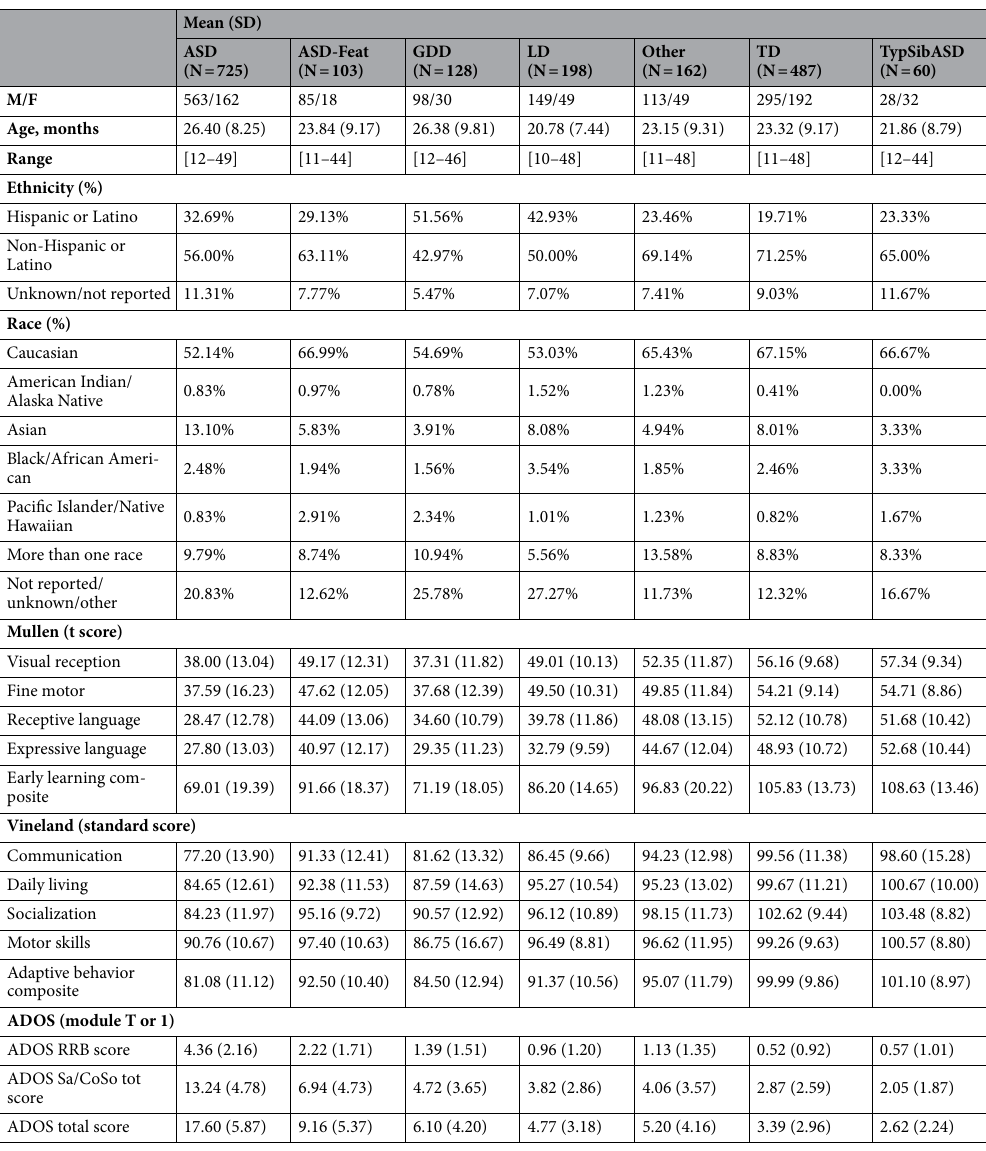
Table 1. Summary of clinical characteristics for 1,863 toddlers who completed The GeoPref Test. Values are presented as means (standard deviations are noted in parentheses unless otherwise noted, and